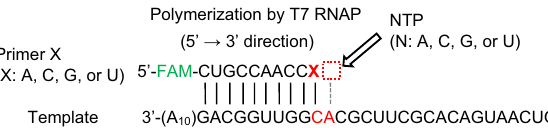
Figure 1. Sequences of template and primer RNAs used in this study. X indicates each 3 ′ terminal base of primers. The dashed square on the right side of “X” of the primer end indicates the position of incorporated NTP. Four different primers and four NTPs were used. As a primer end, primer G is the matched one complementary to the C base of the template. As an incorporated NTP, UTP is the matched one complementary to the A base of the